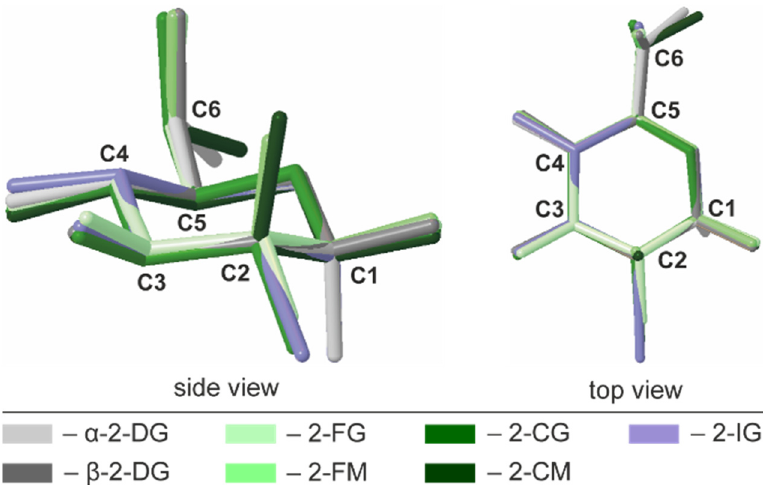
Figure 3. Superimposed structures of investigated halogen derivatives compared to α - and β -anomers of their parent compound.